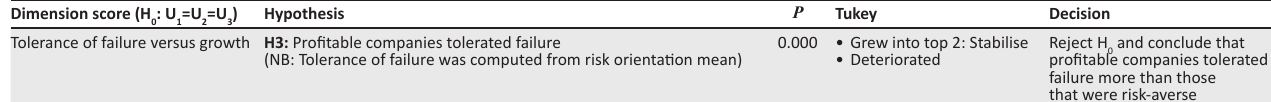
TABLE 4: Summary of analysis of variance tests on the dimensions of tolerance of failure. Dimension score (H